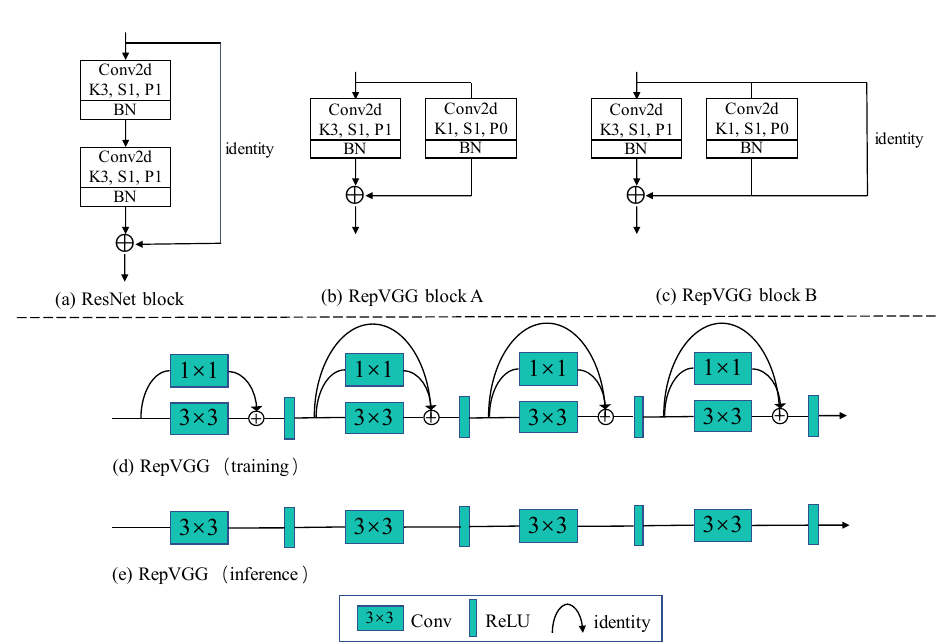
Figure 3. The structure of RepVGG: ( a ) Residual block of ResNet; ( b ) Residual block A of RepVGG; ( c ) Residual block B of RepVGG; ( d ) Sketch of RepVGG structure during training; ( e ) Sketch of RepVGG structure during inference.